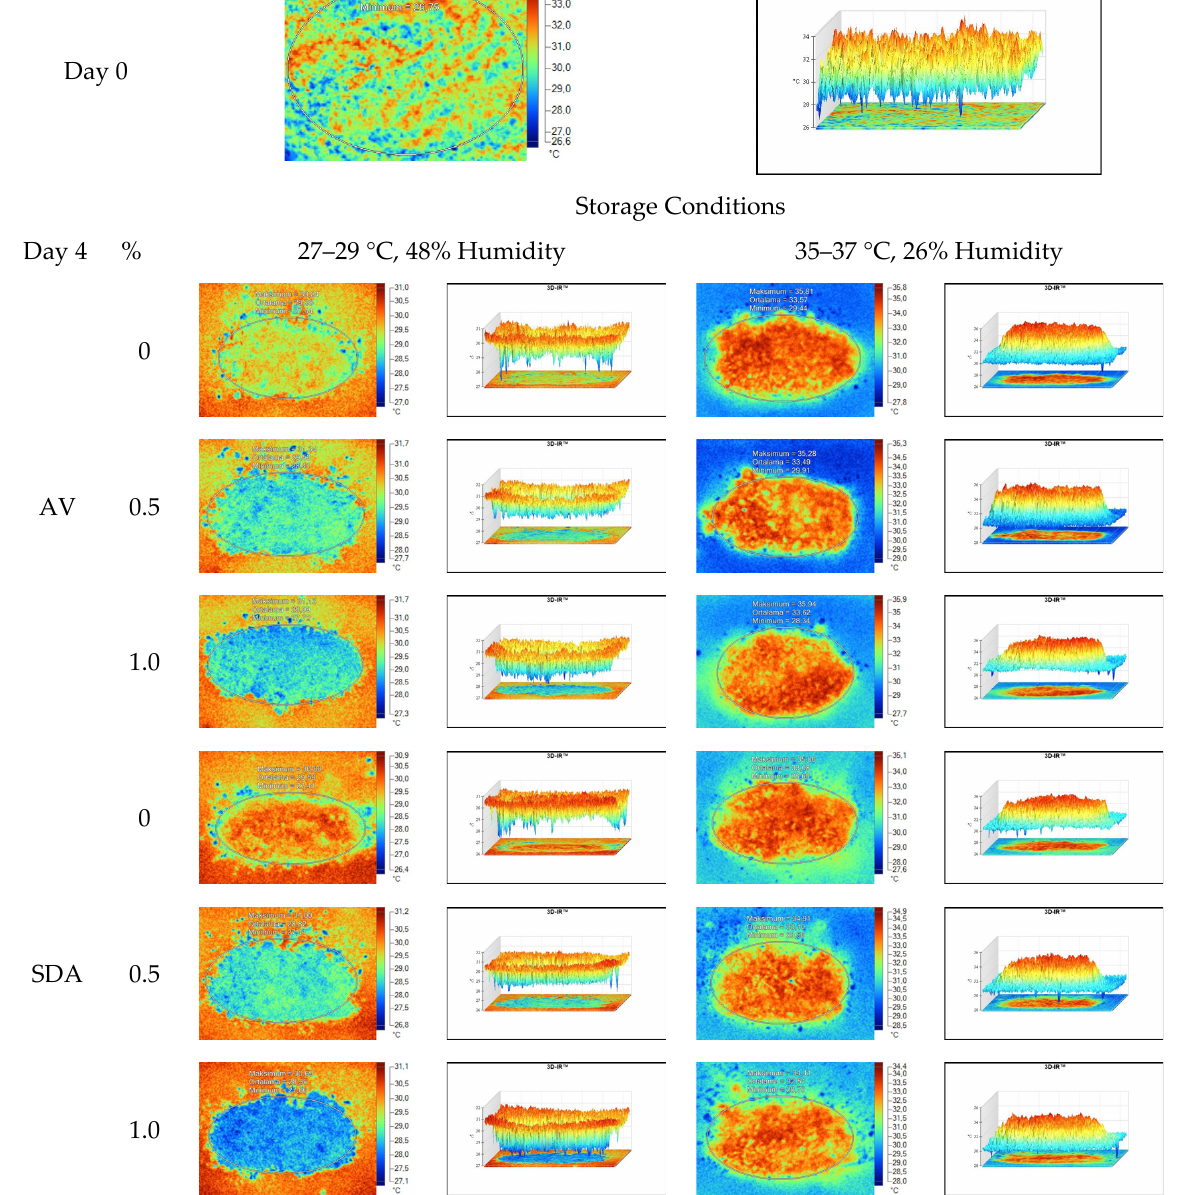
Figure 6. Thermal camera imaging samples of aerobic stability on day 4 (Ambient temperature = 22 °C; AV: Apple vinegar; SDA: Sodium diacetate).